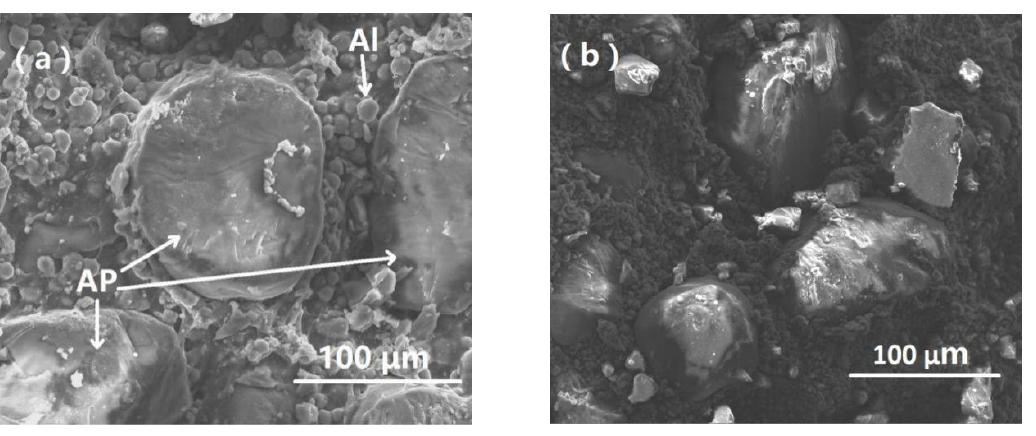
Figure 5. Deformation processes of H-80W recorded by a high-speed digital camera under a strain rate of 2460 s −1 . The green numbers in the images correspond to the numbers marked in Figure 4.